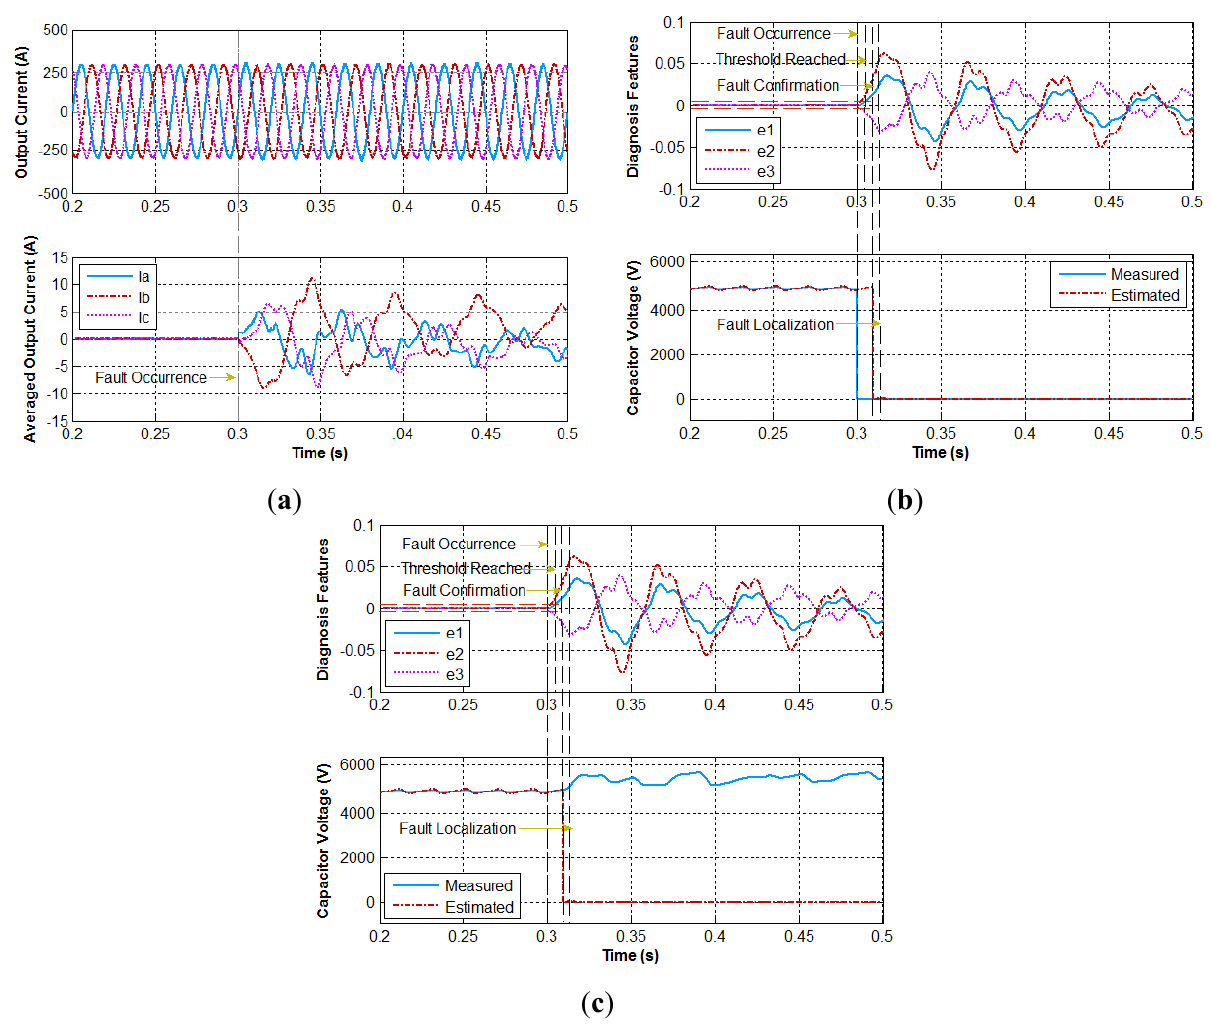
Figure 15. Short-circuit fault in T 1 or T 2 under 10 MW. ( a ) Output current and their averaged values; ( b ) Diagnosis features and capacitor voltages in SM1; ( c ) Diagnosis features and capacitor voltages in